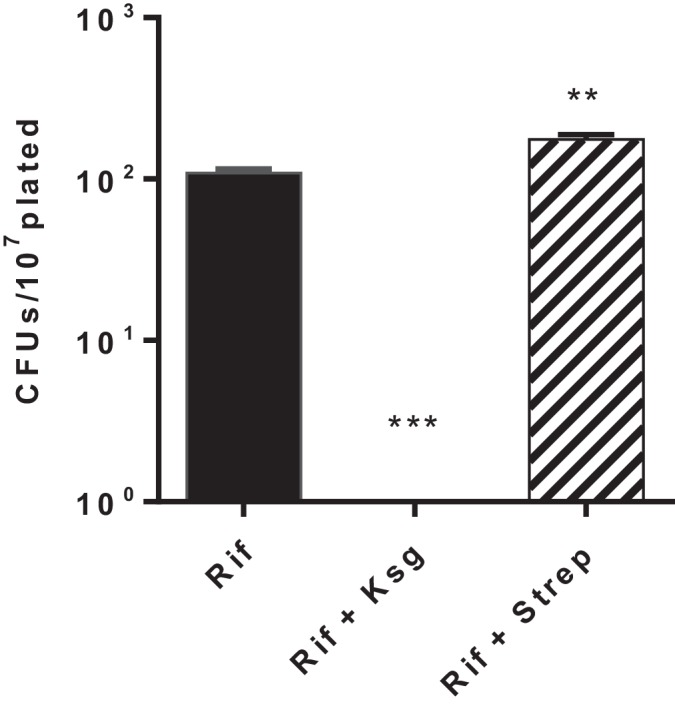
Kasugamycin but not streptomycin decreases Msm rifampicin plate tolerance.Cells were plated on rifampicin-agar ± kasugamycin (50 µg/ml) or streptomycin (0.2 µg/ml) or LB alone. Survival fraction on rifampicin was measured after 5–7 days. **p<0.01, ***p<0.001 by Student’s t-test.